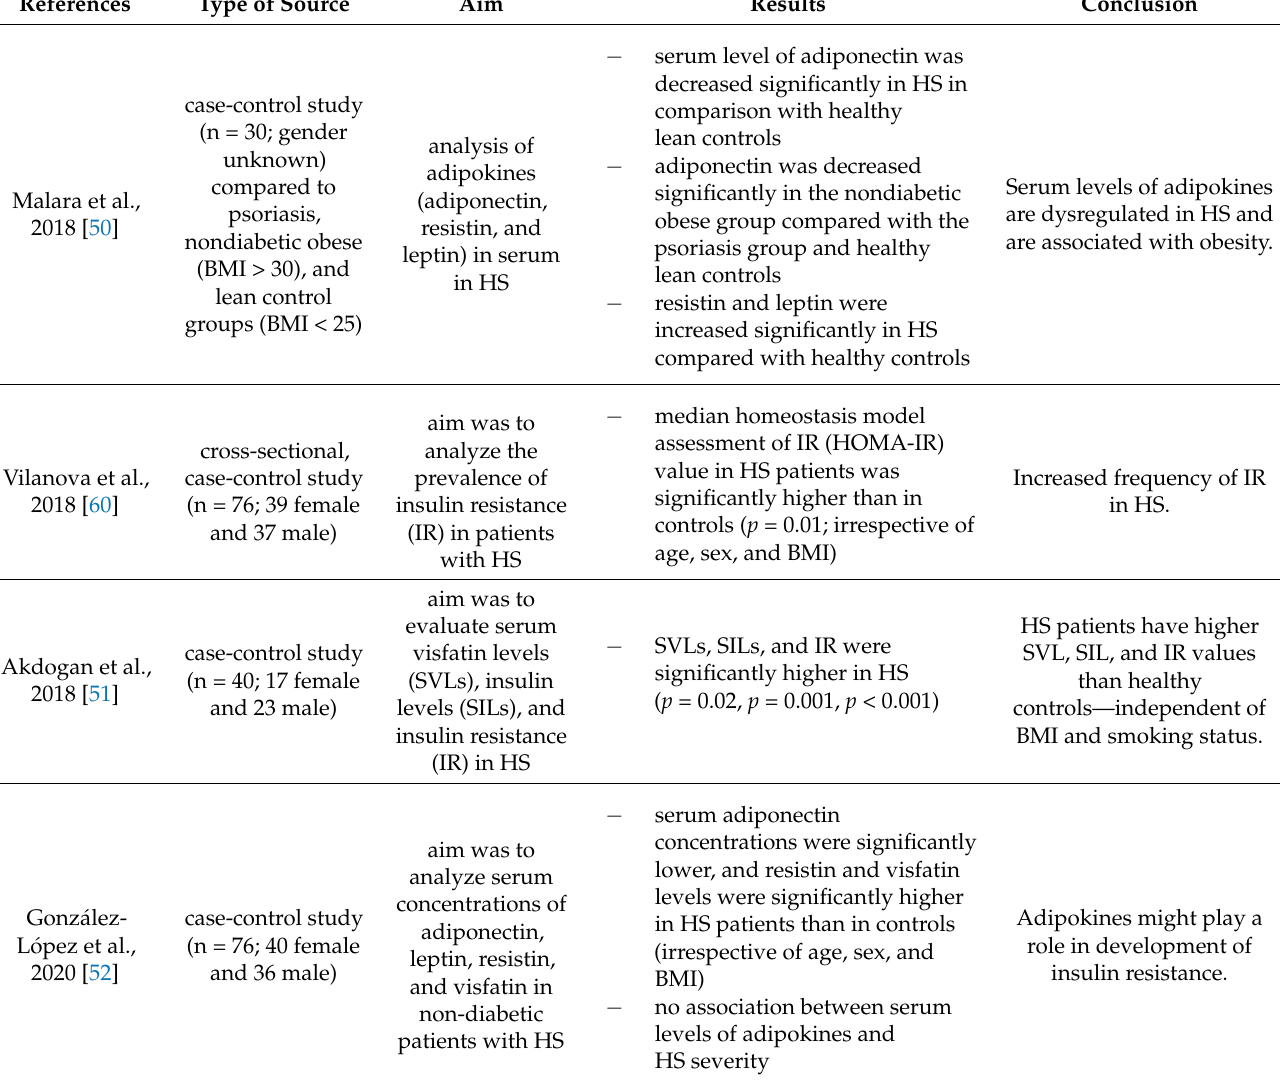
Table 6. Current findings about adipokines and insulin resistance in